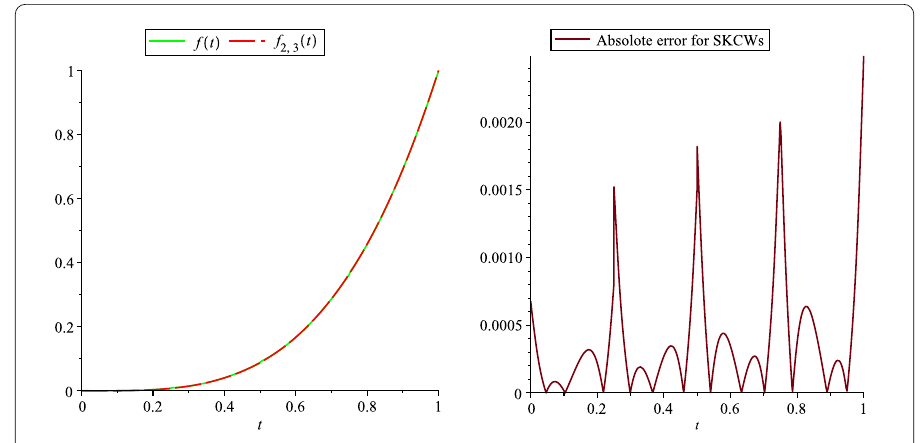
Figure 1 Graphs of the obtained results at the interval [0,1) by the SKCWs method with k = 2, M = 3, for Example 6.1